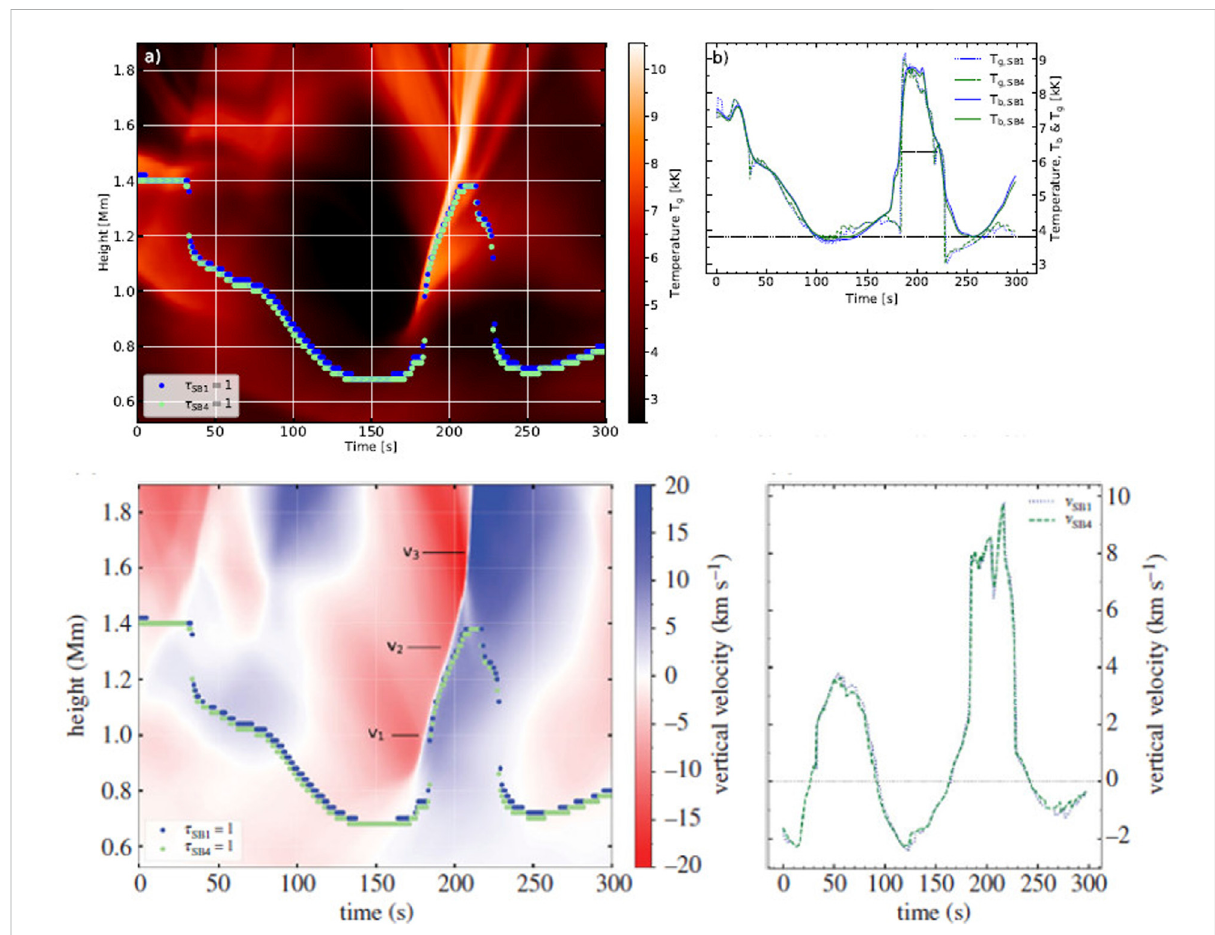
FIGURE 13 Topleft[panel (A) ]:Gastemperatureasafunctionoftimeandheightforasimulatedshockwave.Theblueandgreendotsindicatetheformation heights for emission at 1.309 (SB1) and 1.204 mm (SB4), respectively. Top right [panel (B) ]: Time pro fi le of the brightness temperature at SB1 (solid blue) and SB4 (solid green) as well as of the gas temperature at the τ = 1 heights of the corresponding wavelengths (blue/green dotted). Bottom panels: same as top panels but for the vertical velocity of the gas (from Eklund et al.,